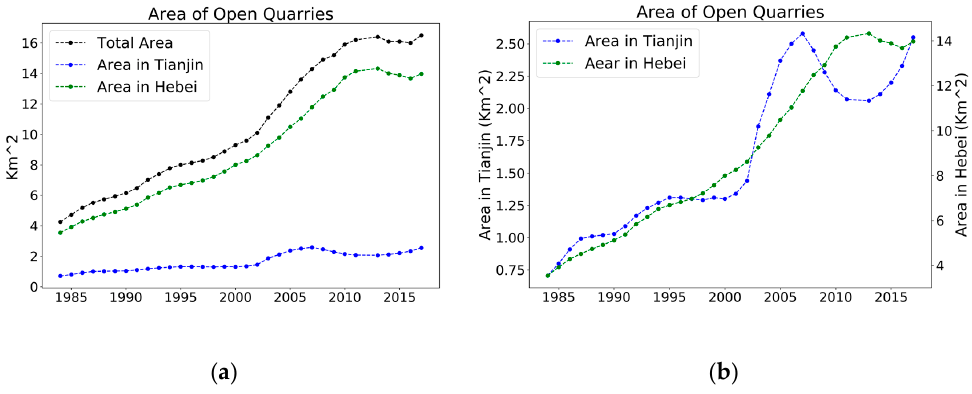
Figure 10. ( a ) Quarry area in two regions from 1984 to 2017; ( b ) Quarry area depicted with two y-axes for the two regions.